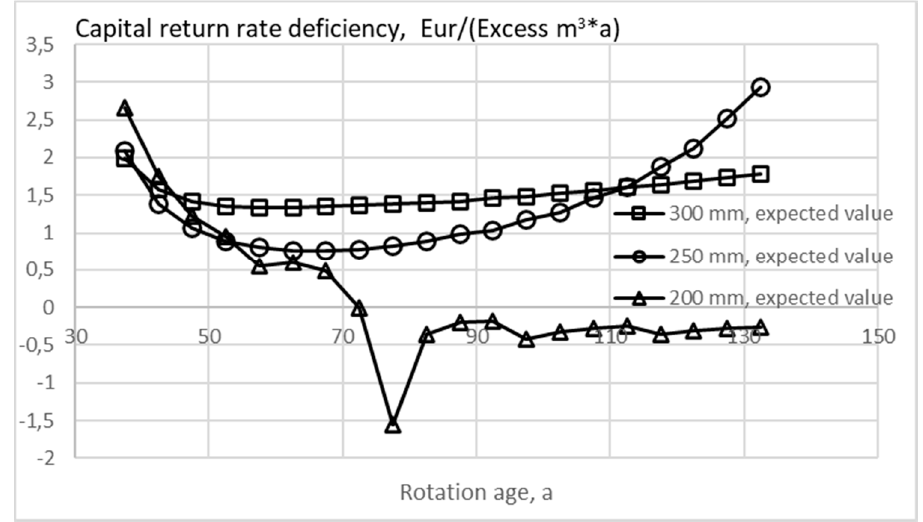
Figure 8. Capital return rate deficiency in Euros per excess commercial volume and year, for different rotation ages and three different cutting diameter limits (200 mm, 250 mm, and 300 mm).